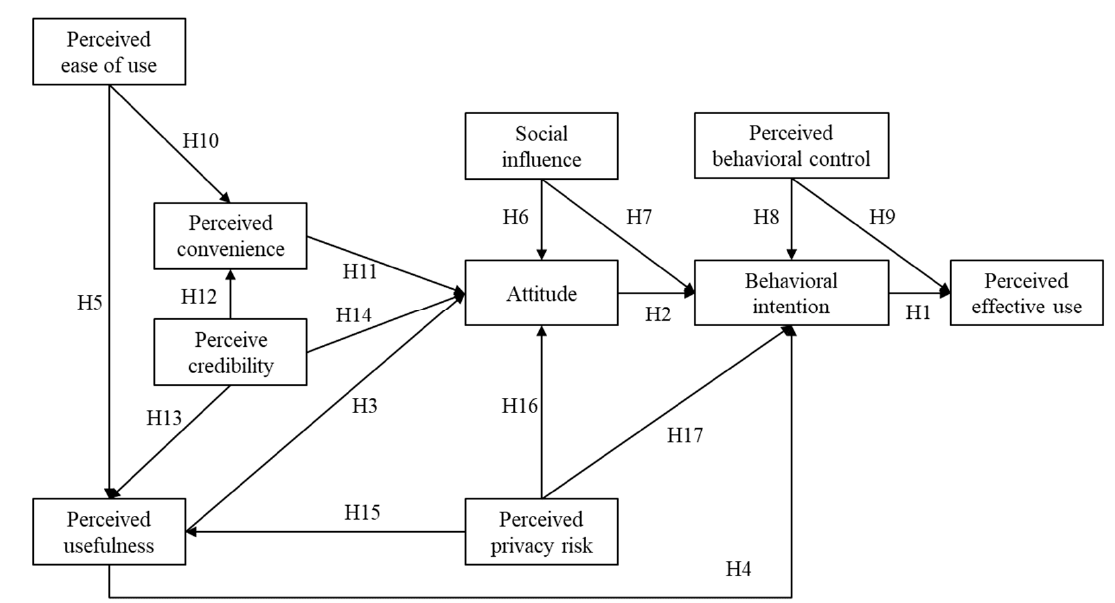
Figure 1. The proposed MMP acceptance model.